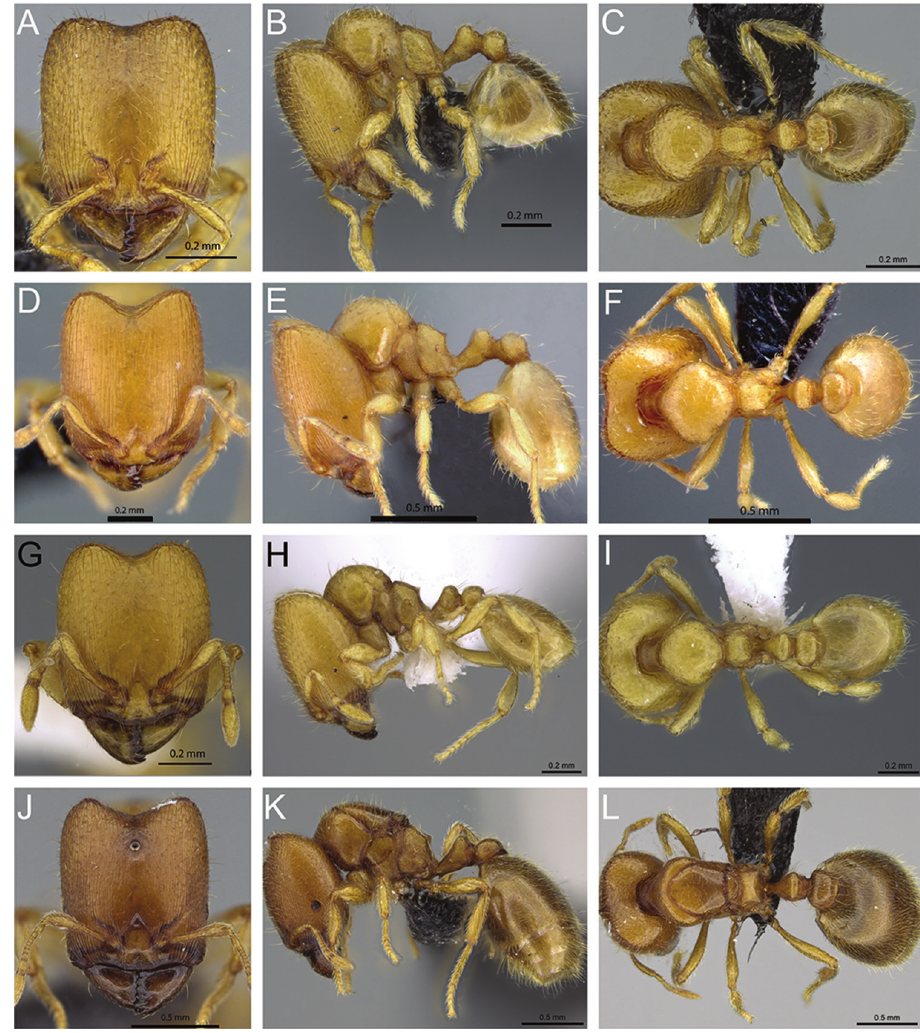
Figure 53. Intermediates of Carebara nosindambo . Major workers, CASENT0073098: A head in full- face view B body in profile view C body in dorsal view. CASENT0002849: D head in full-face view E body in profile view F body in dorsal view. CASENT0227032: G head in full-face view H body in profile view I body in dorsal view. CASENT0072632 J head in full-face view K body in profile view L body in dorsal